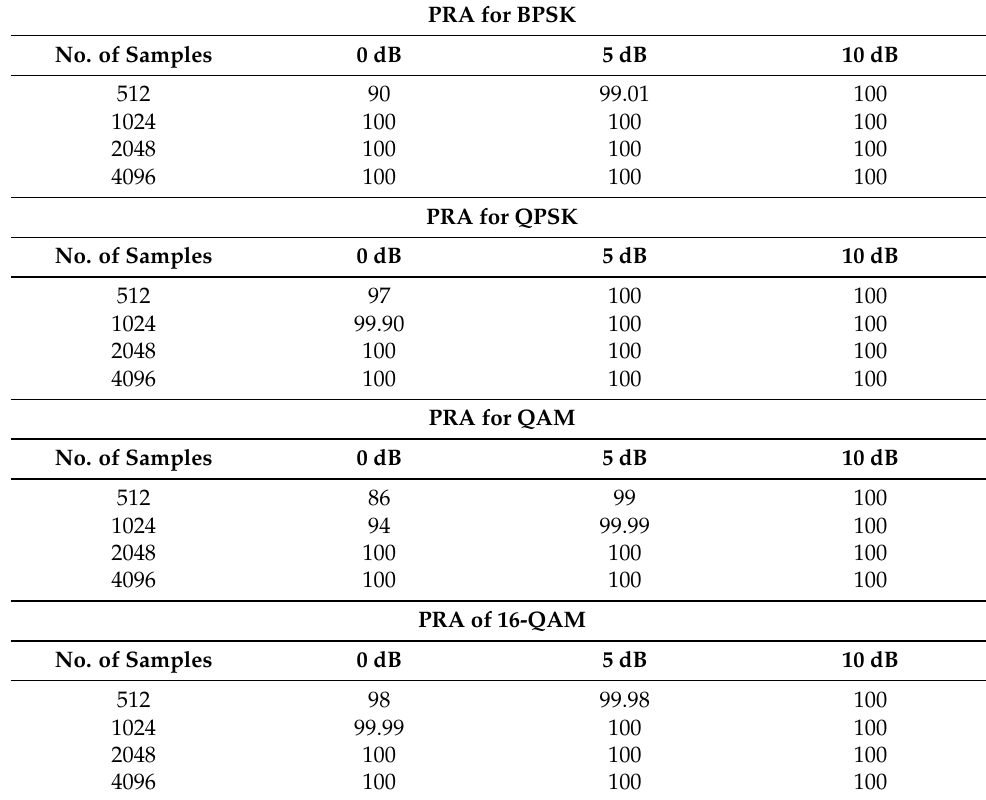
Table 4. Percentage recognition accuracy on the AWGN